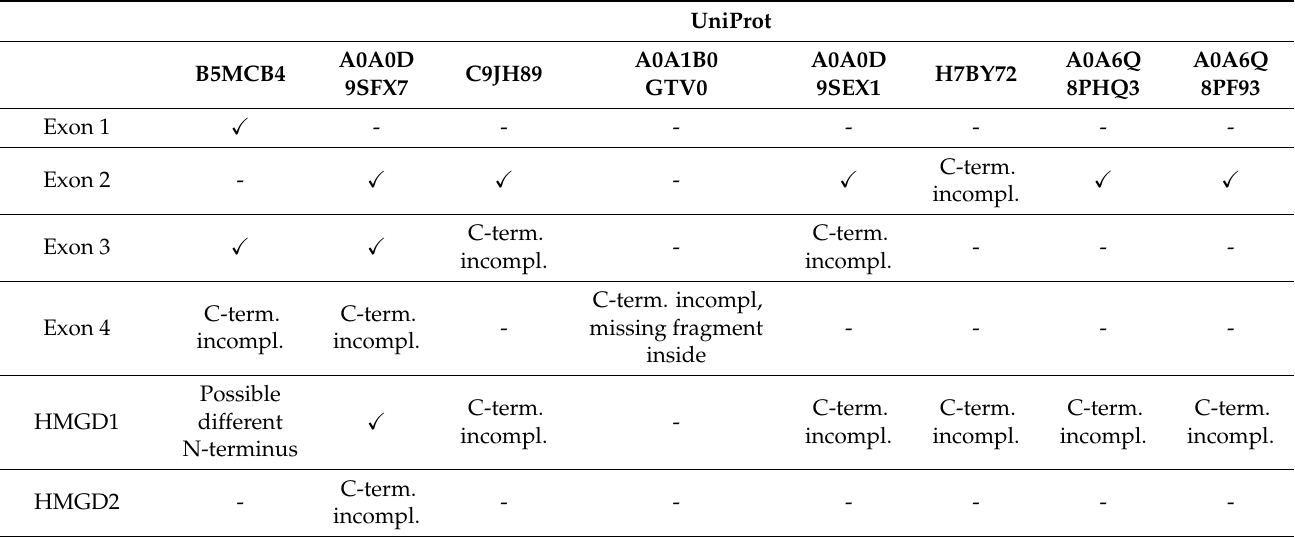
Table 4. NLS1-2, AT-hook 1-2, and CTD β sequences were not found in any of the potential isoforms from UniProt (Updated 15 October